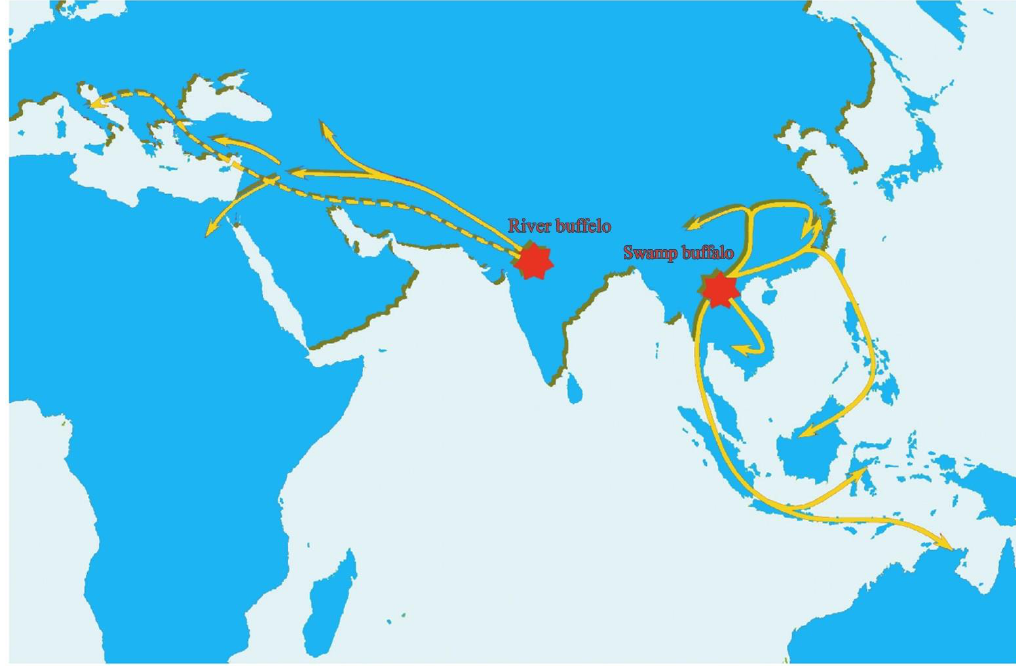
Figure 3. A proposed pattern of riverian and swamp buffalo migration. The dashed arrow points to an initial and independent migration way that might have led river buffaloes into Europe [45] (figure reproduced by Rehman et al., 2021, with the permission of authors).